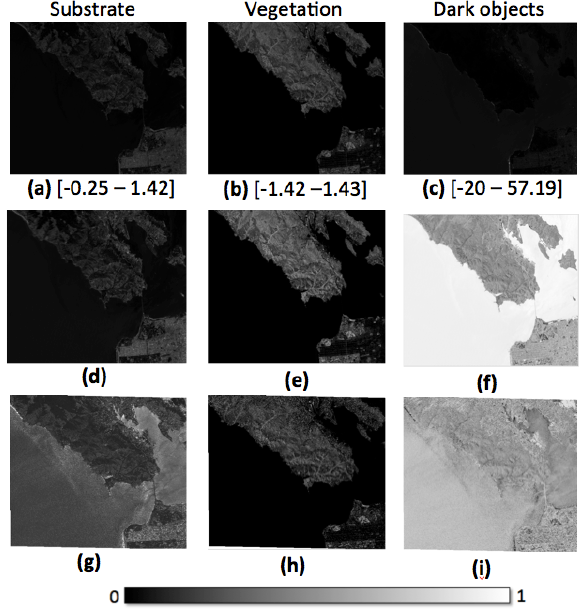
Figure 7. Endmember fractions of SVD from Landsat data using SUnSAL (first row), CSUnSAL (second row) and from WV-2 data (third row). For SUnSAL, the range of abundance fraction values for S, V and D are specified in square brackets underneath each figure [minimum abundance value – maximum abundance value]. For other abundance maps, 0 (black) indicates absence of a particular class and 1 (white) indicates full presence of that class in a pixel as shown in the legend.